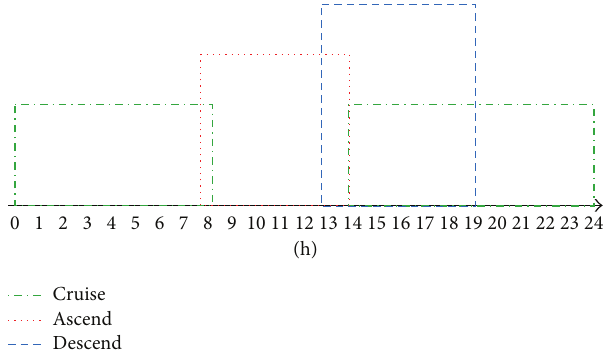
Figure 9: Recommended mission profile phase region.